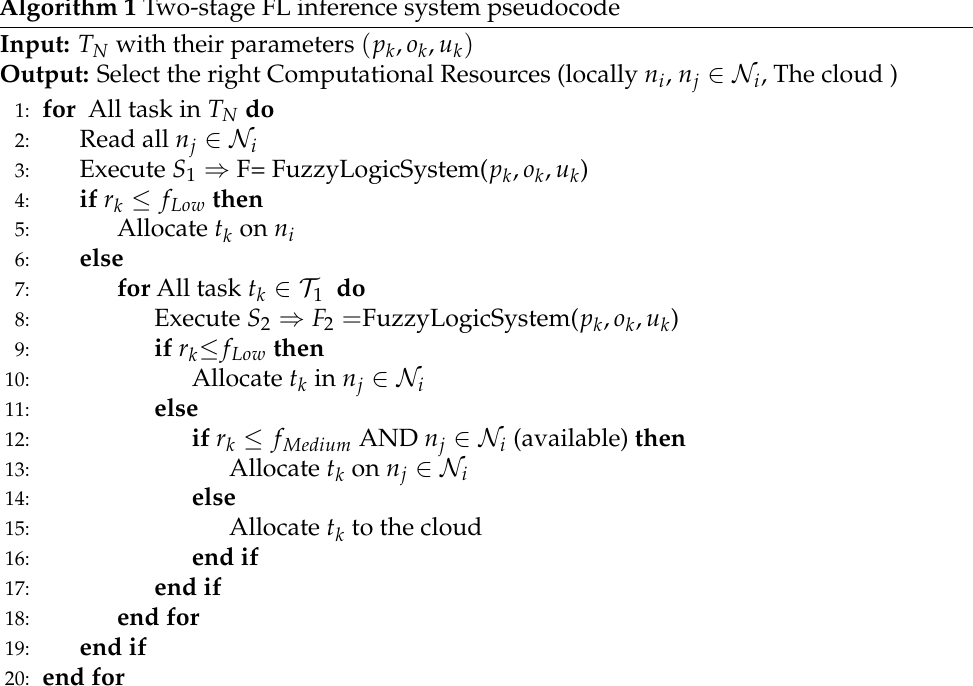
Algorithm 1 Two-stage FL inference system